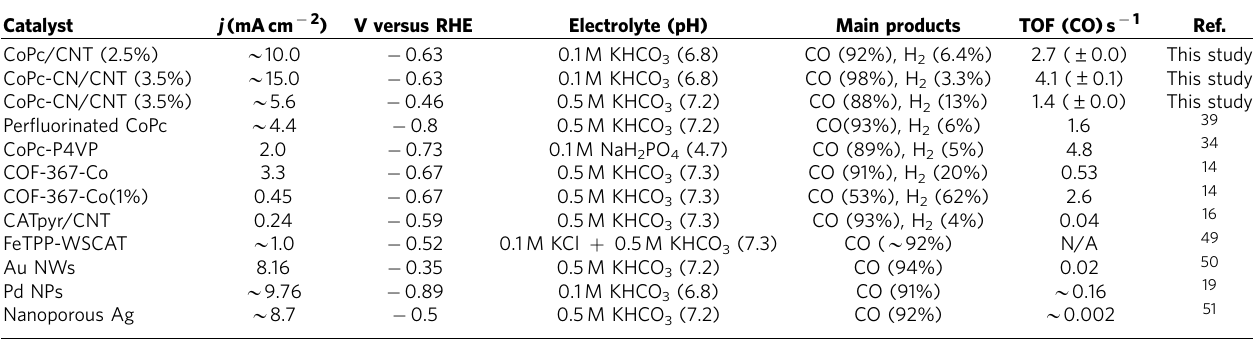
Table 1 | Comparison of the CoPc/CNT and CoPc-CN/CNT hybrid catalysts with reported state-of-the-art high-performance CO-selective CO 2 reduction electrocatalysts working in aqueous